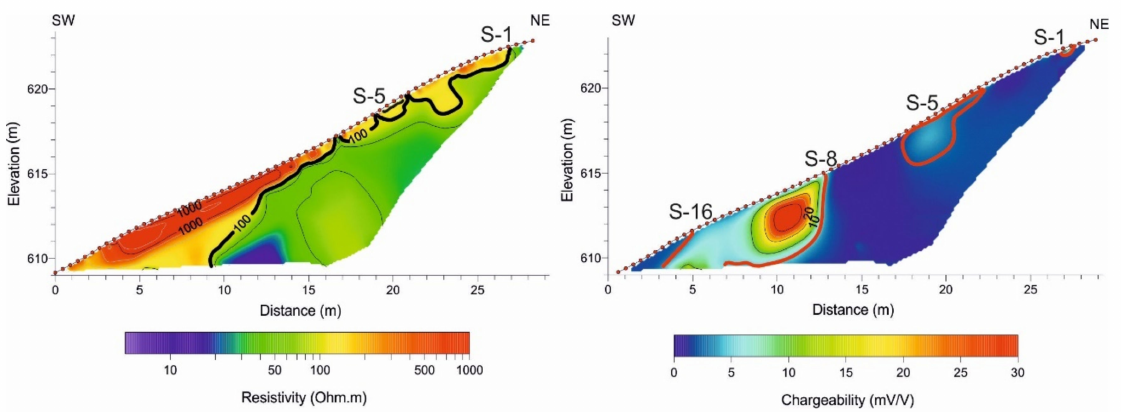
Figure 3. Image of the actual electrical resistivity (Ohm m) and chargeability (mV.V − 1 ) of the ERT-IP profile along the slope of the dam (modified from [38]). The position of the samples of fines with the highest concentration of metals is